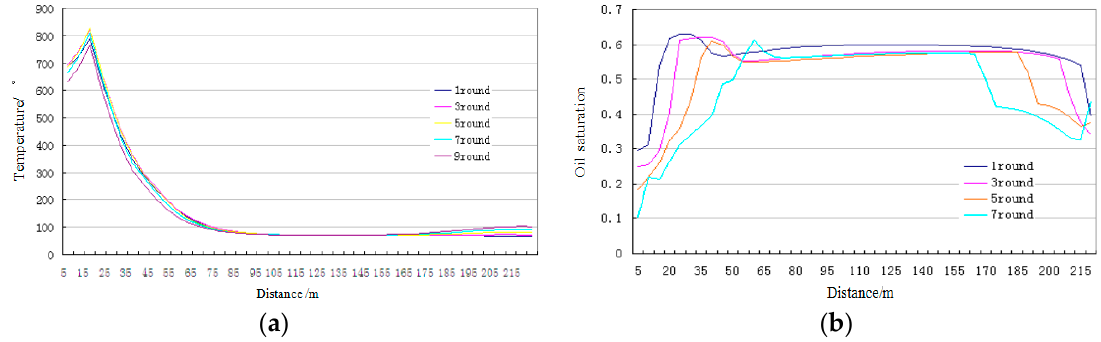
Figure 3. The temperature change of the firing front and oil saturation change under different huff and puff rounds. ( a ) Temperature change of the firing front; ( b ) oil saturation change.